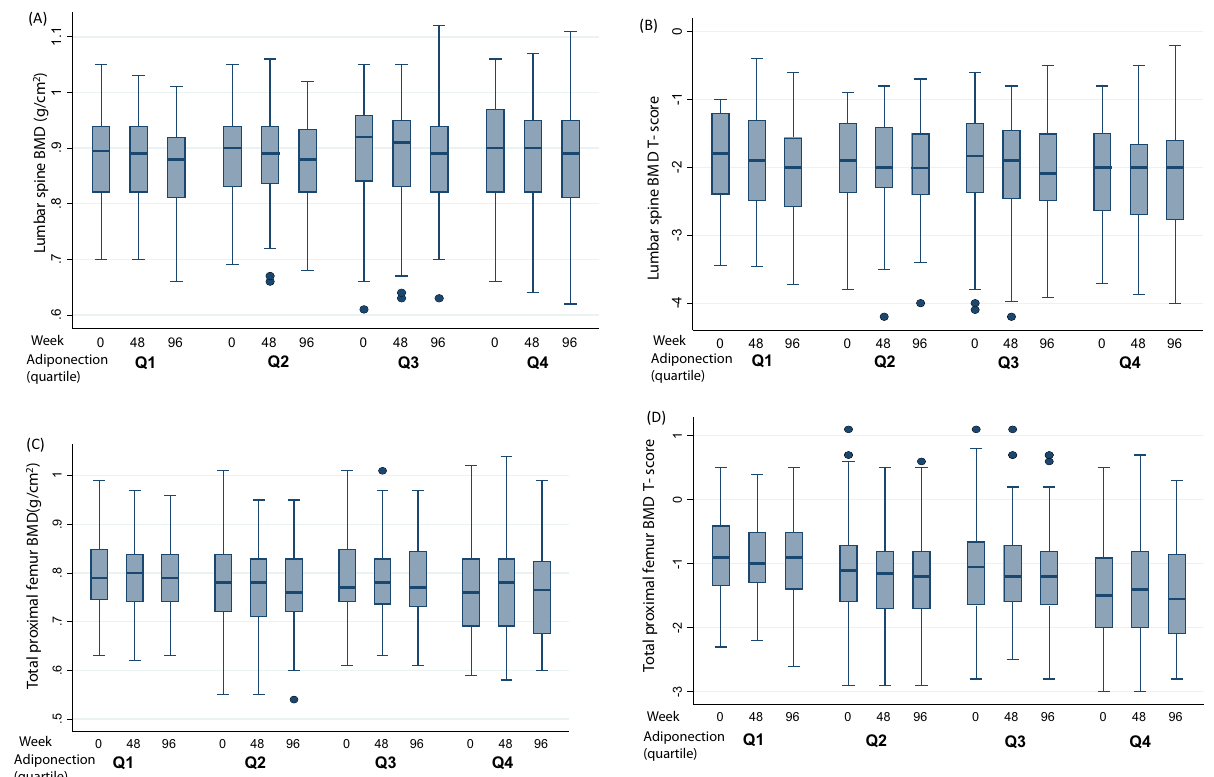
Figure 1. Whiskers plots of BMD and T-score at baseline, week 24 and week 96 in the quartiles of serum adiponectin levels: BMD (g/cm 2 ) ( A ), T score ( B ) at lumbar spine and BMD (g/cm 2 ) ( C ), T-score ( D ) at total proximal femur.